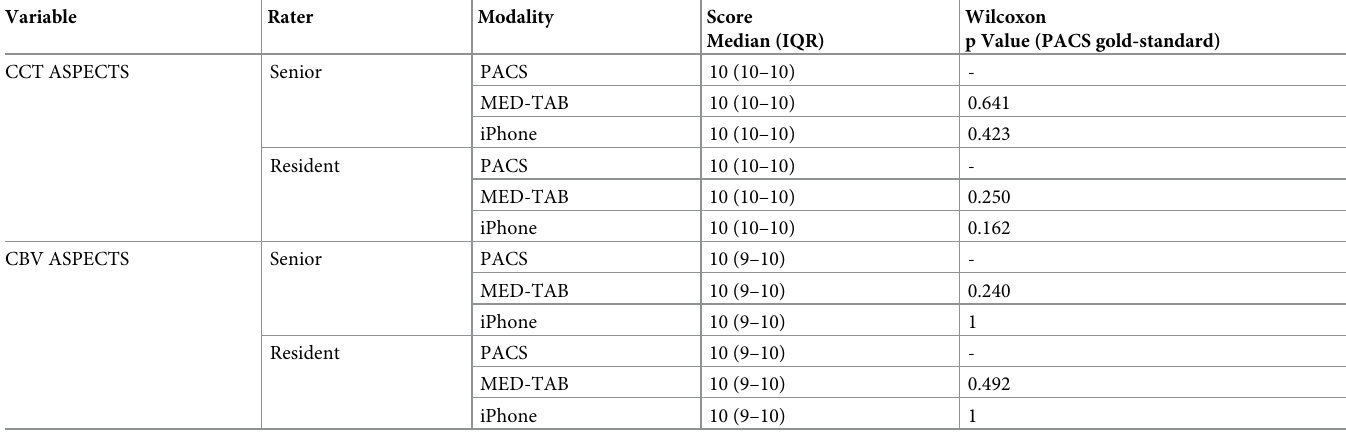
Table 3. CCT and CBV ASPECTS on the MED-TAB/iPhone plus 7 and GE PACS.